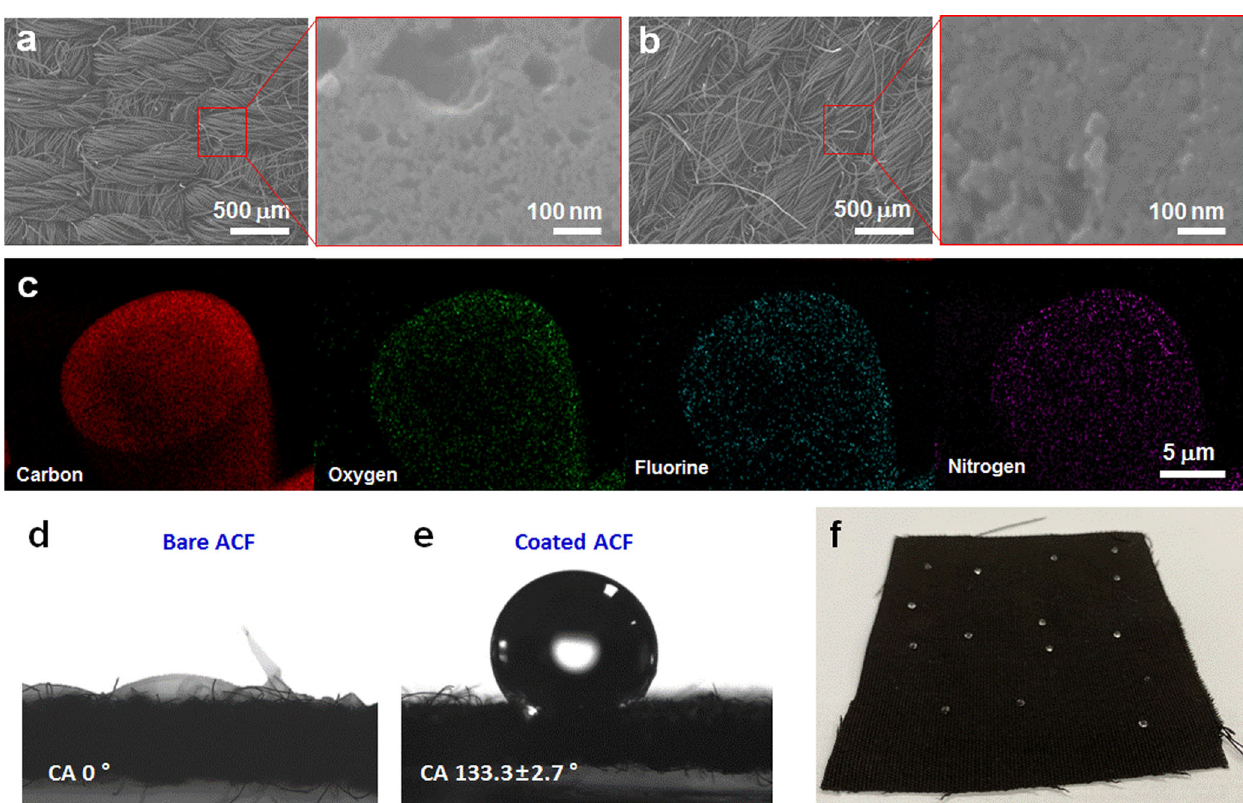
Fig. 3 Characterization of F-PU in-and-out coated ACF. Field emission scanning electron microscopy (FE-SEM) images of ( a ) bare activated carbon fabric (ACF) and ( b ) F-PU in-and-out-coated ACF. c FESEM/energy dispersive spectroscopy (EDS) of the F-PU in-and-out-coated ACF